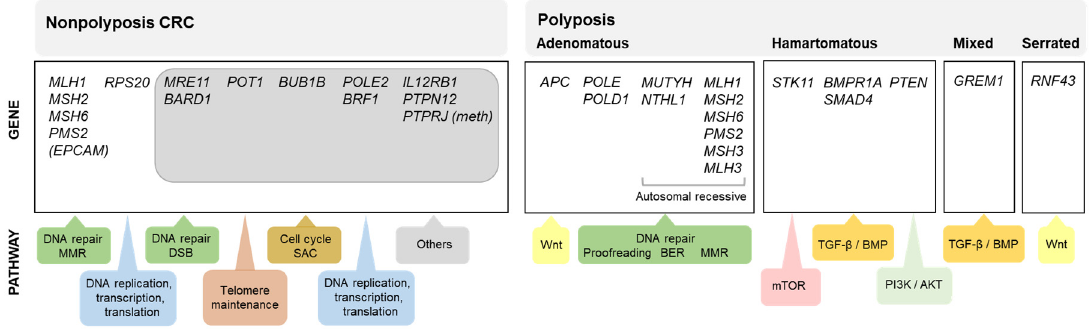
Figure 1. Schematic representation of colorectal cancer predisposing syndromes, causal genes, and affected molecular pathways. Genes shaded in grey correspond to the most promising proposed candidate genes. Abbreviations: BER, base excision repair; DSB, double strand breaks; meth, promoter hypermethylation; MMR, DNA mismatch repair; SAC, spindle assembly checkpoint.